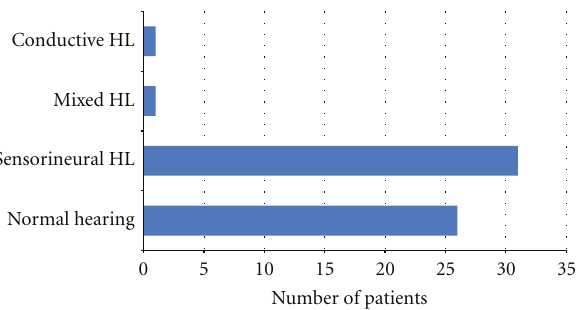
Figure 2: Hearing level in the study group. Hearing loss (HL).